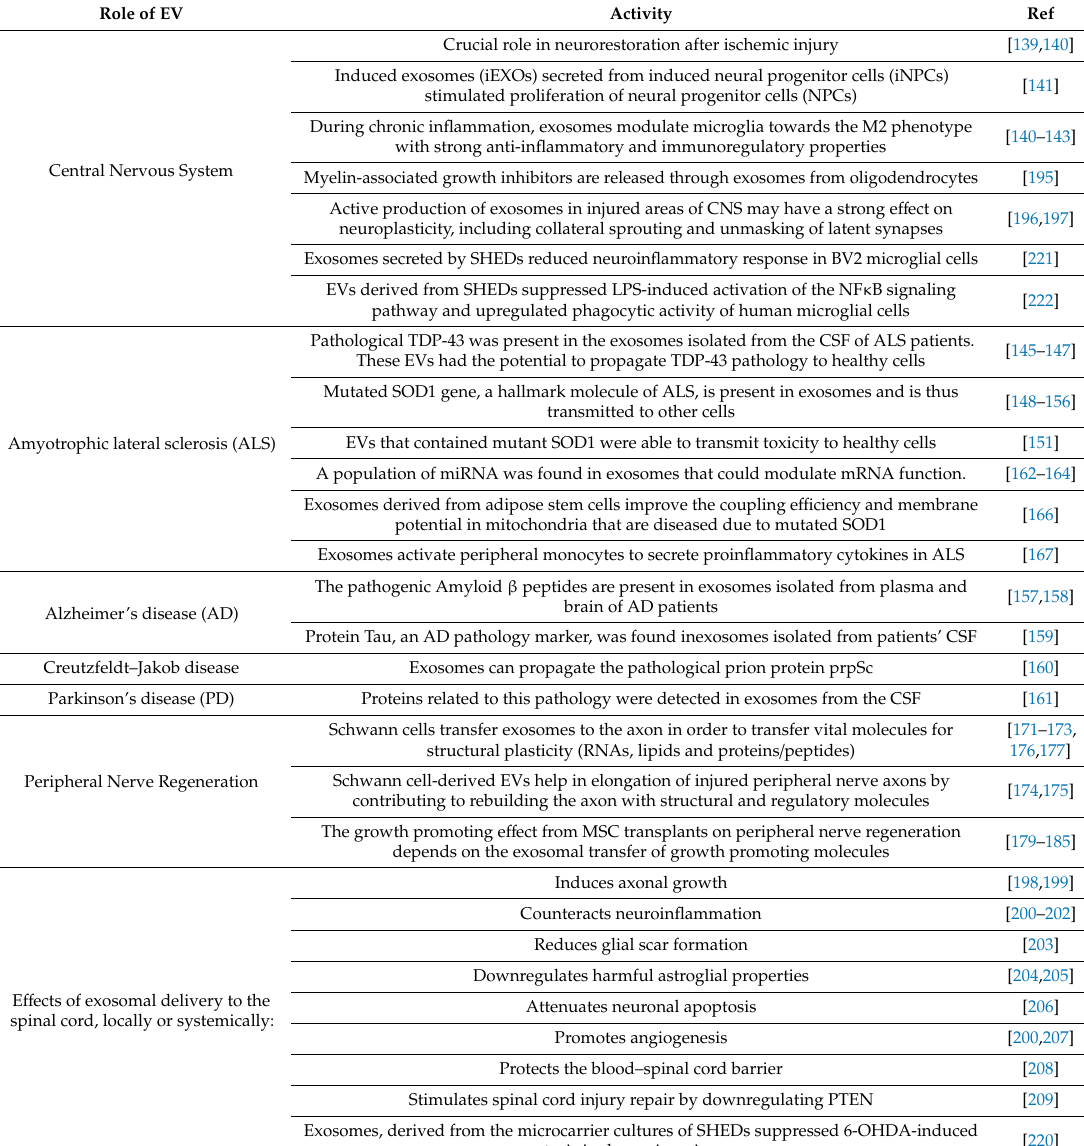
Table 1. Functions of EVs in neuroinflammation / neurodegeneration.